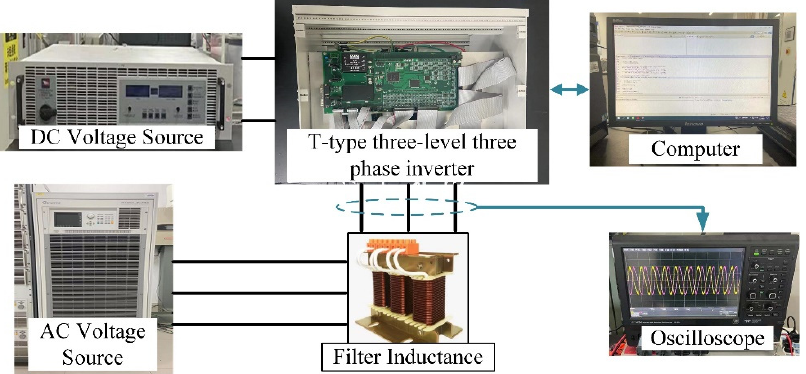
Figure 7. T-type three-level three-phase grid-connected inverter experimental platform. Table 2. System and control